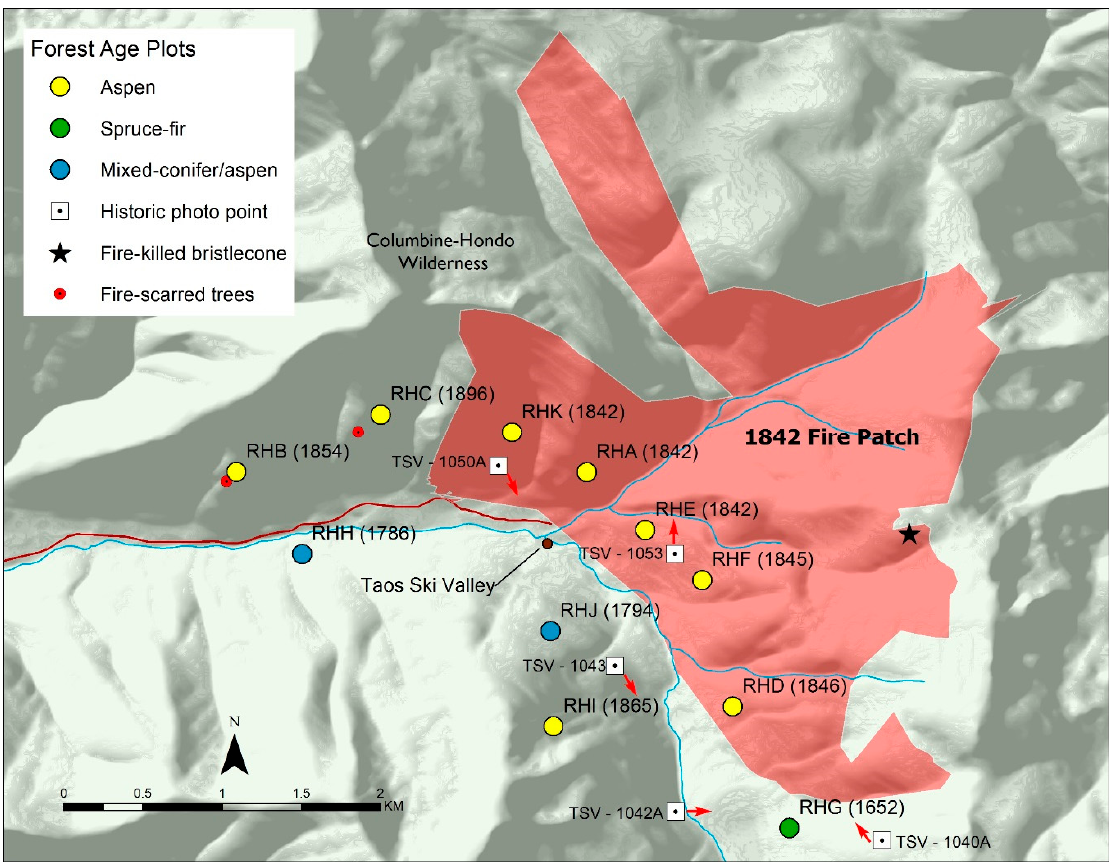
Figure 7. A map of the Upper Rio Hondo and Taos Ski Valley with the locations of the tree ring data and historical photographs that were used to estimate the minimum extent of the 1842 high-severity fire patch (red). The years adjacent to the plot codes (e.g., 1842) indicate the oldest tree-ring dates for living trees at each forest-age plot. The approximate directions of the historical photographs (e.g., TSV-1042A) are indicated by the red arrows.